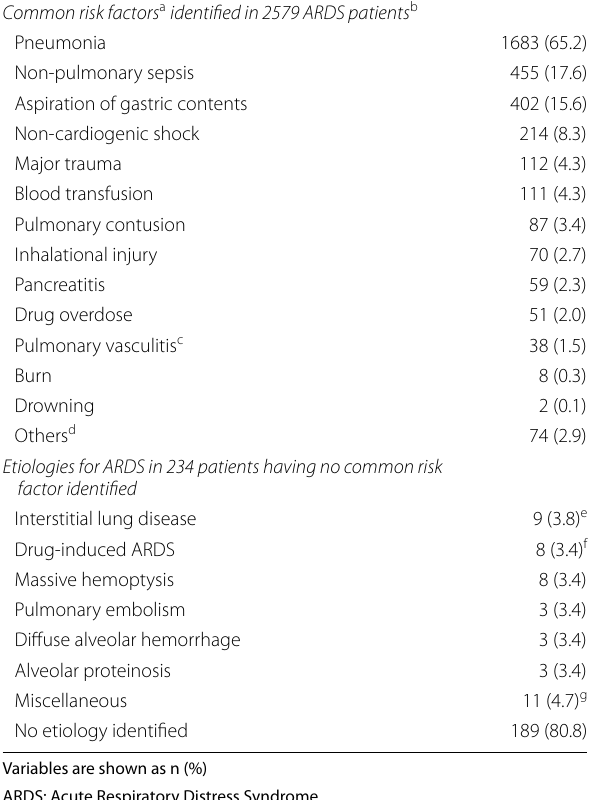
Table 3 Risk factors and etiologies identified for ARDS patients meeting ARDS criteria within 48 h of acute hypox-